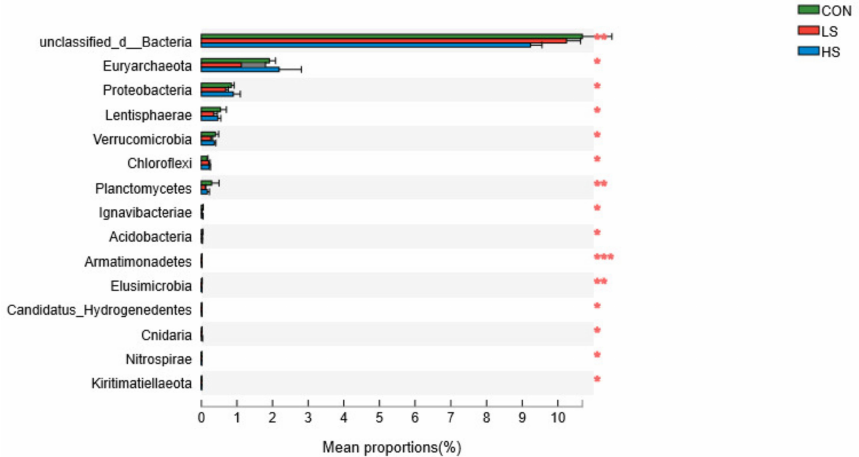
Figure 2. Effect of selenium yeast on rumen dominant bacteria at phylum level (>1%; as a percentage of the total sequence). CON = basal diet; LS = basal diet + 2.4 mg/kg SY; HS = basal diet + 4.8 mg/kg SY. * p < 0.05, ** p < 0.01, *** p <